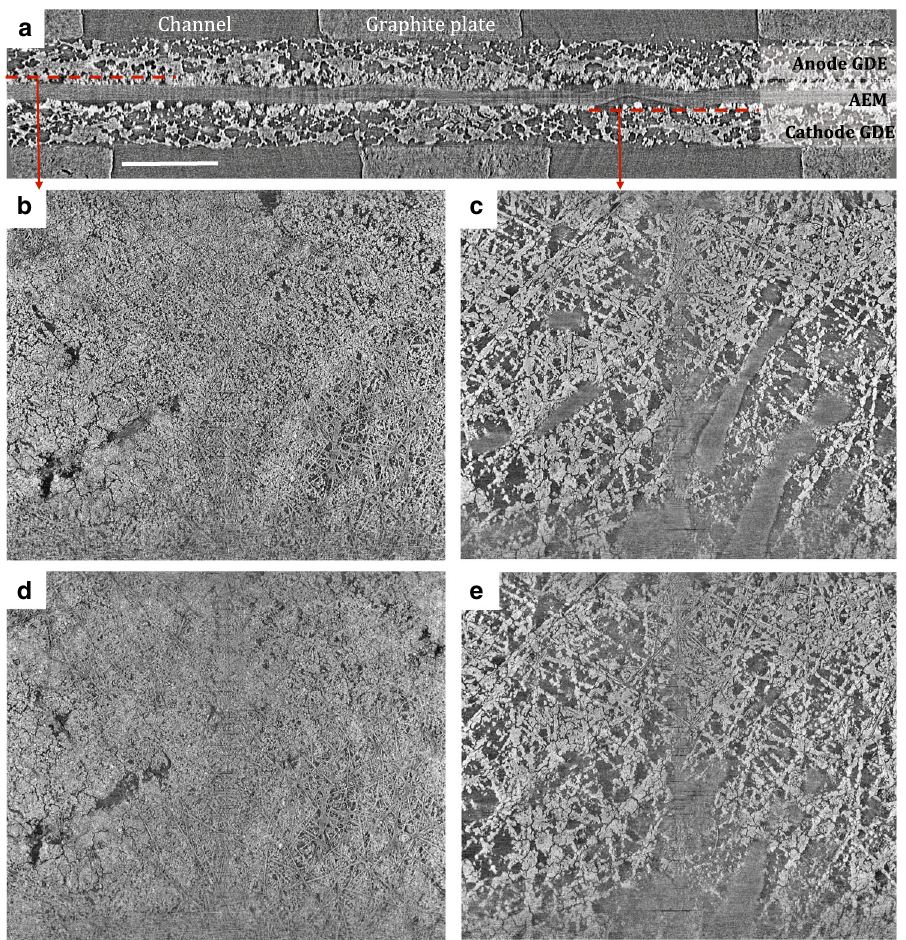
Fig. 7 Morphology of electrodes with added PTFE. AMFC micro X-ray computed tomography images: ( a ) cross-section of the MEA showing the position of anode GDE, AEM, and cathode GDE of the imaged area; scale bar = 500 μ m, ( b ), ( c ) longitudinal sections of anode and cathode GDEs at OCV under 100% RHs, ( d ), ( e ) longitudinal sections of anode and cathode GDEs at 0.1 V under 100% RHs. The anode and cathode used in this measurement contained 20% wt PTFE in the GDLs and 8% wt PTFE in the CLs. The anode and cathode loading were 0.70 mg PtRu cm − 2 and 0.60 mg Pt cm − 2 , respectively. H 2 /O 2 reacting gases were both fed to the cell at 200